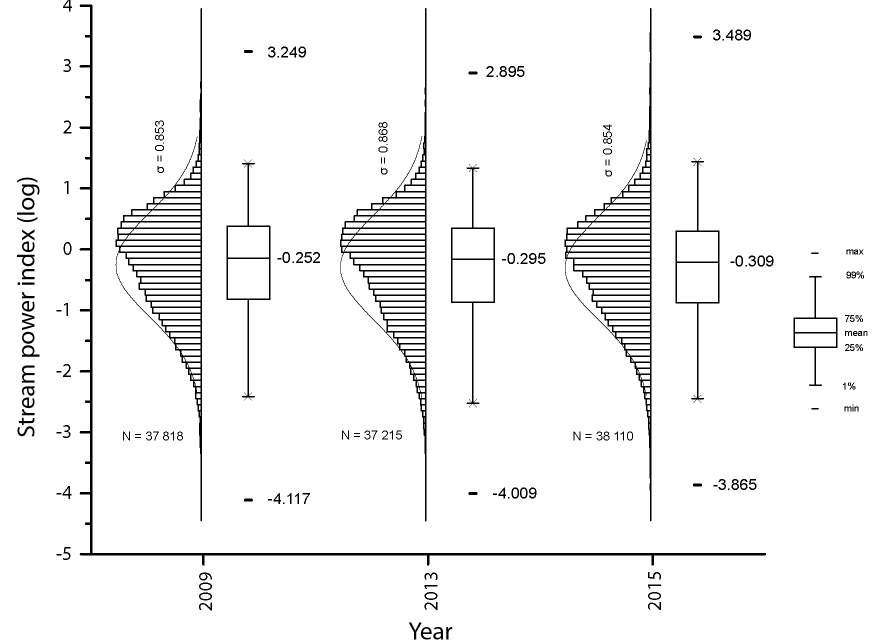
Figure 15. Box plot and statistical distribution of the SPI for the epochs 2009 (TLS), 2013, and 2015 (both